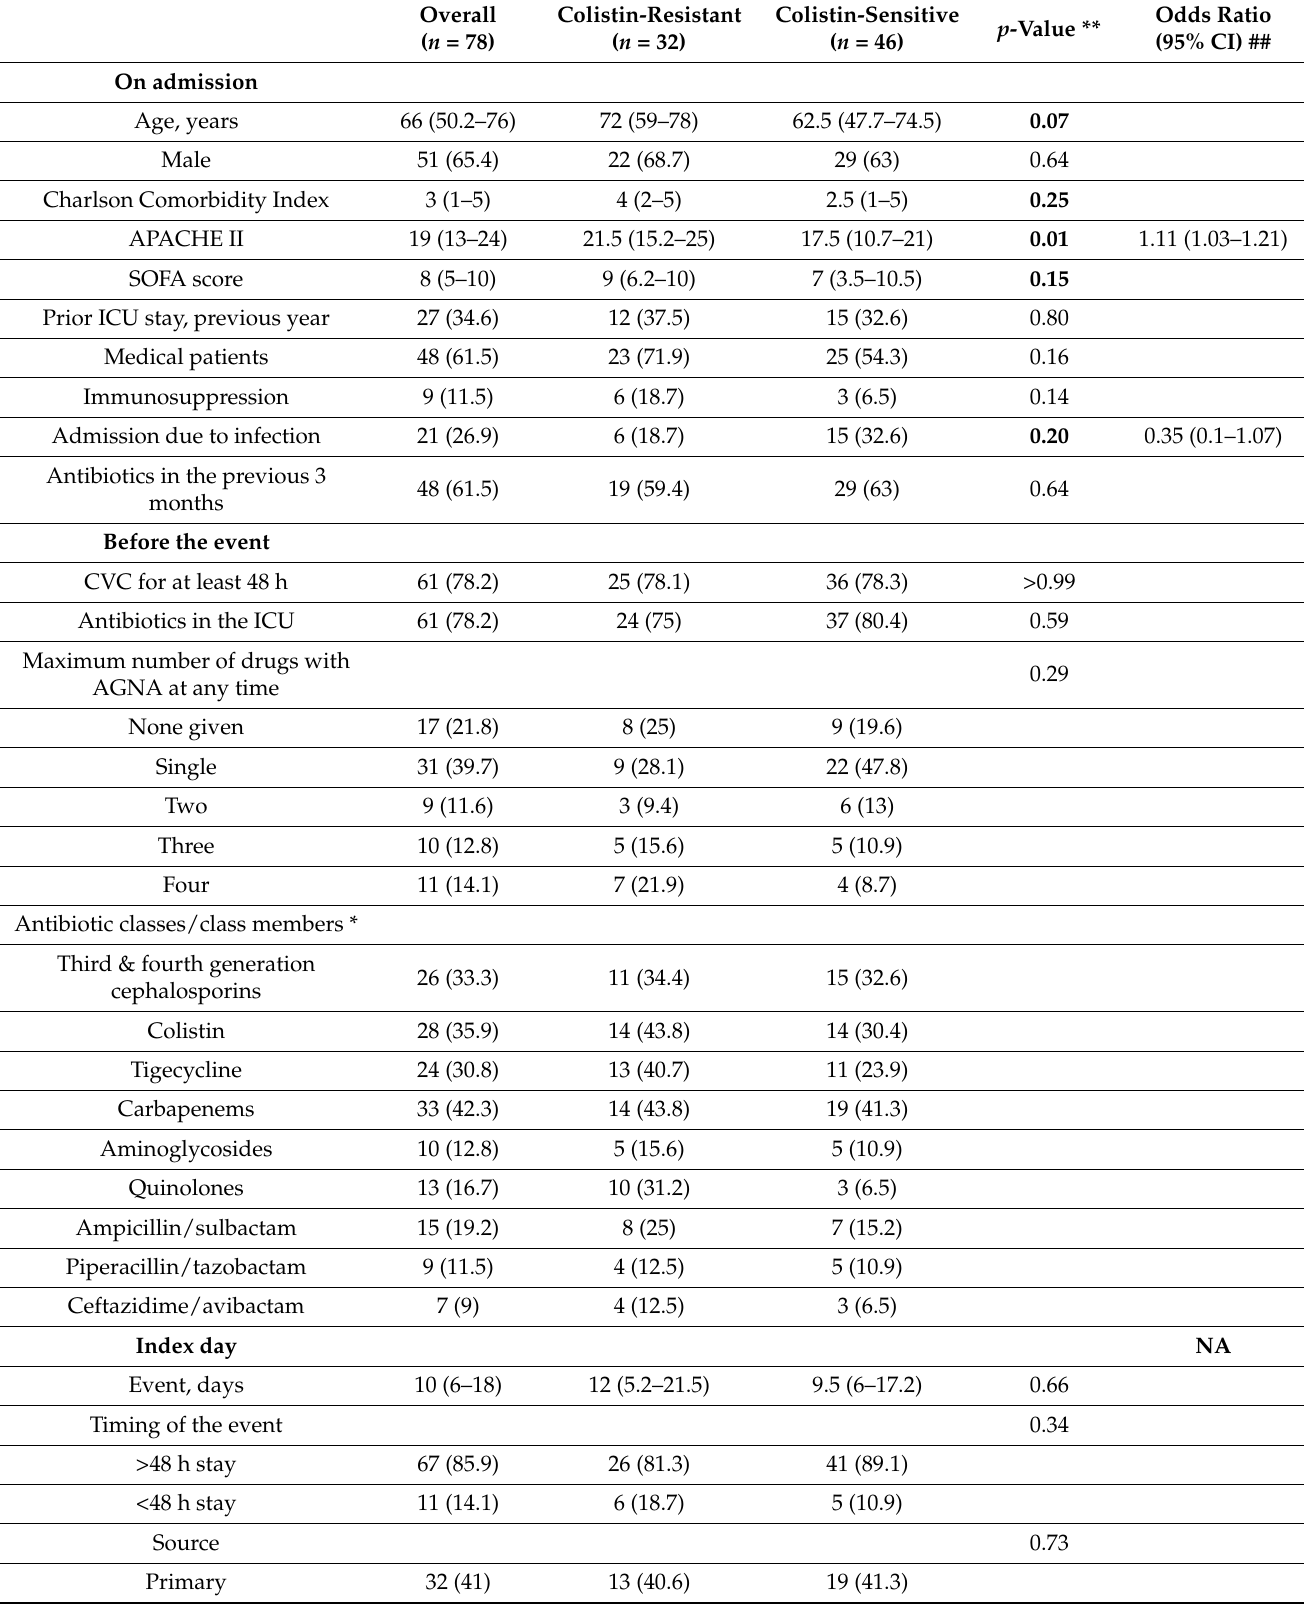
Table 1. Patient characteristics on admission, before the bloodstream infection, and on the day of the